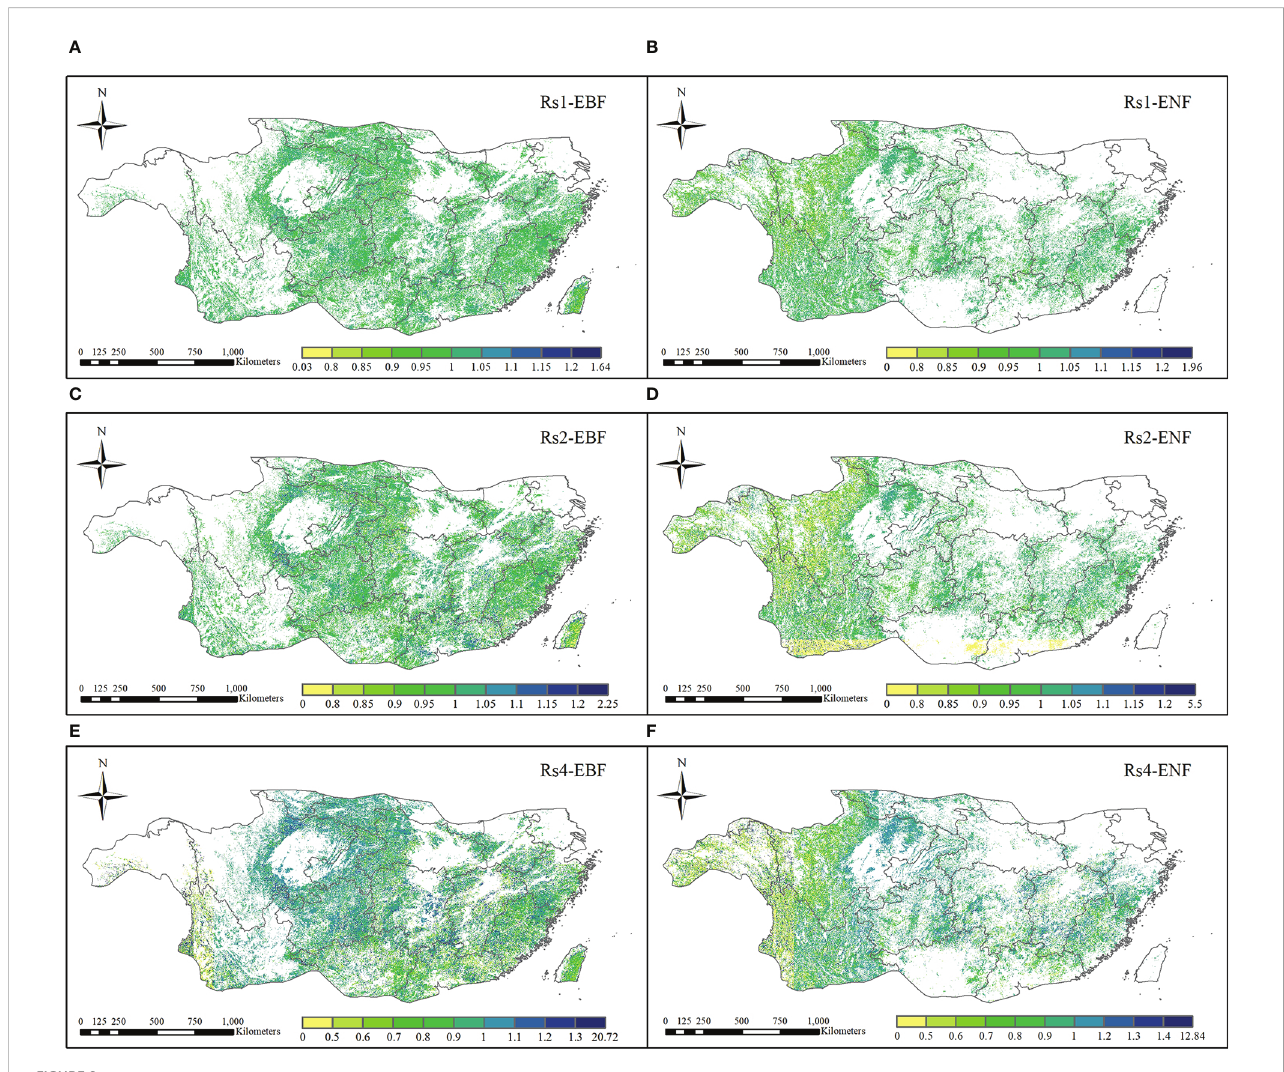
FIGURE 9 Spatial distribution of resilience of EBF and ENF to 2011 extreme drought after the fi rst (A, B) , second (C, D) , and fourth (E, F)